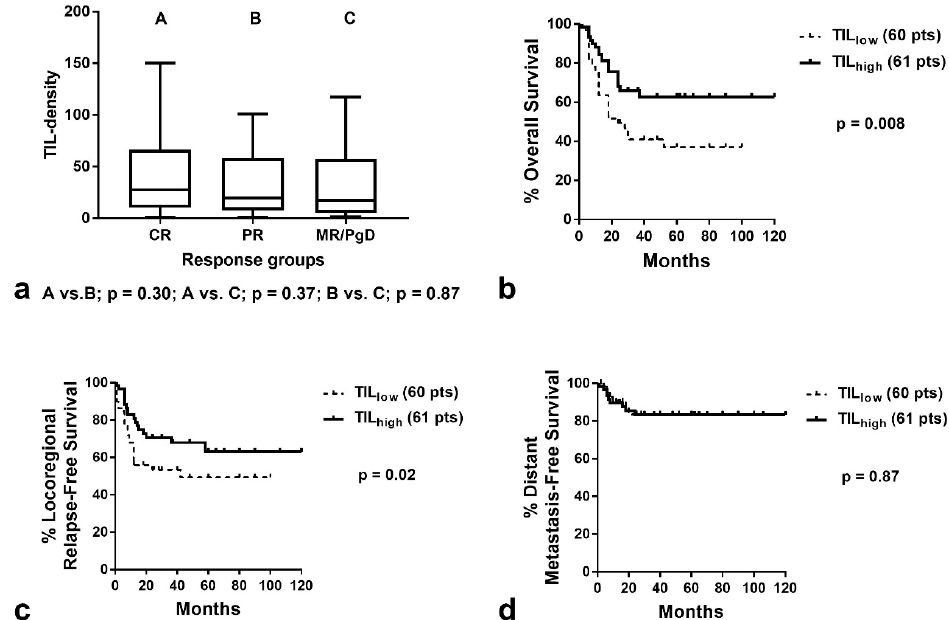
Figure 3. TIL density according to response to RT and Kaplan–Meier survival curves in all patients analyzed: ( a ) TIL density (box and whiskers graphs show the median value, 25th to 75th percentile and range) in patients with CR, (PR and MR/PgD; ( b ) Disease-specific overall survival according to TIL density; ( c ) Locoregional relapse-free survival according to TIL density; ( d ) Distant metastasis-free survival according to TIL density (TIL = tumor-infiltrating lymphocyte, CR = complete response, PR = partial response, MR/PgD = minimal response/progressive disease, A, B, C correspond to the indications shown on x-axis)).